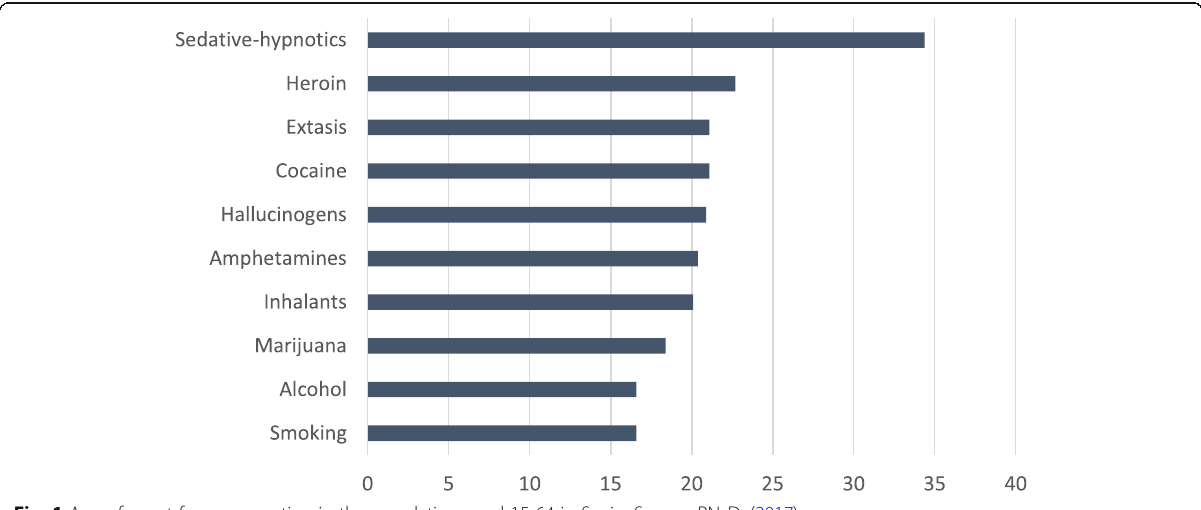
Fig. 1 Age of onset for consumption in the population aged 15-64 in Spain. Source: PNsD,